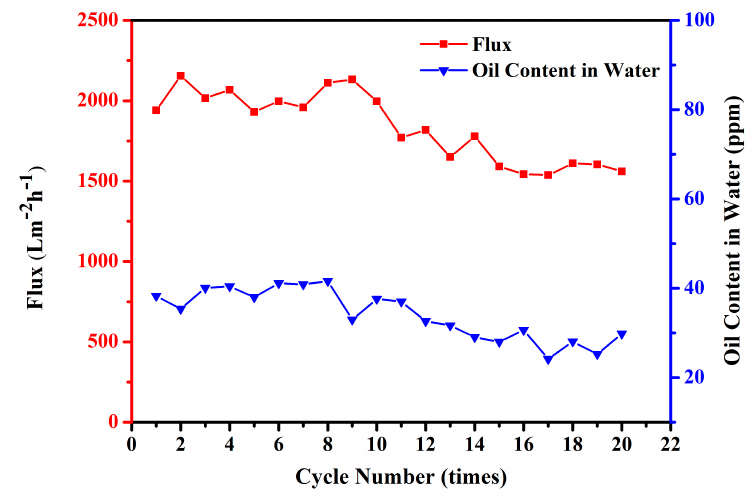
Figure 9. Cycling performance of the CSPNM using n-hexane-in-water emulsion as model feed liquid.